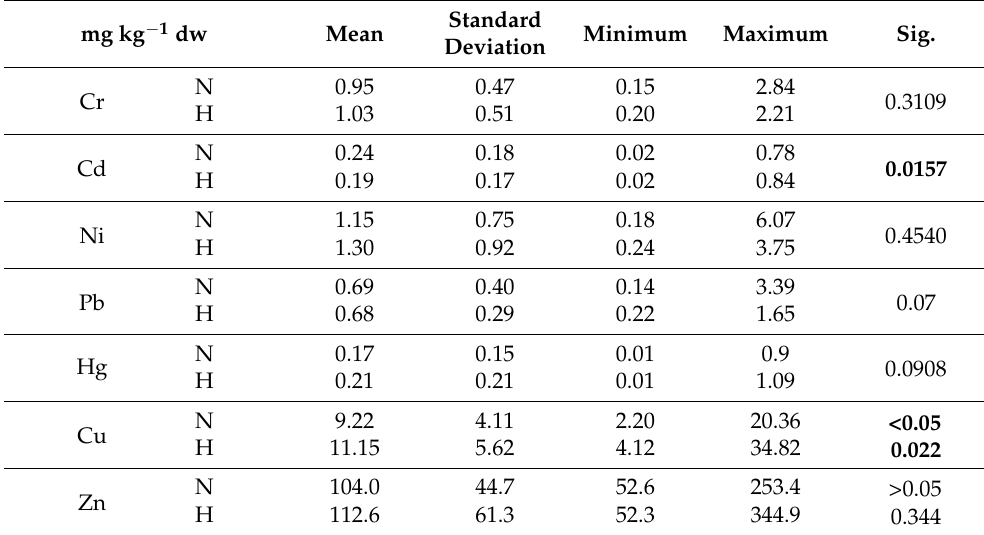
Table 4. Statistical parameters for the measured metals in biota in non-harbour (N) vs. harbour (H) water bodies in VC.